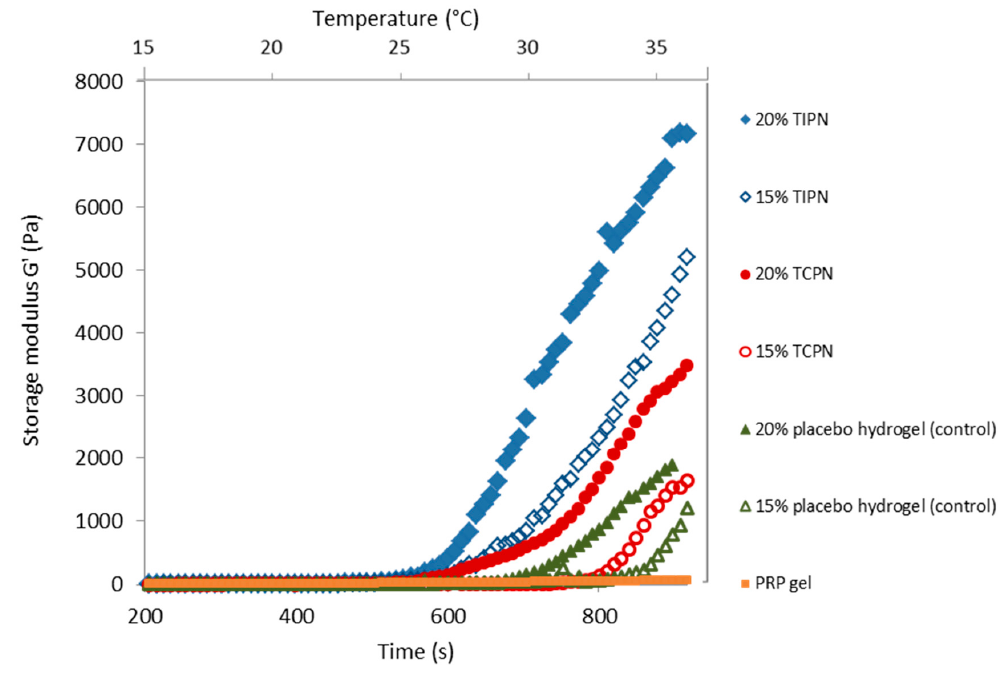
Figure 2. Comparison of storage (G’) moduli as a function of time for different hydrogel formulations.